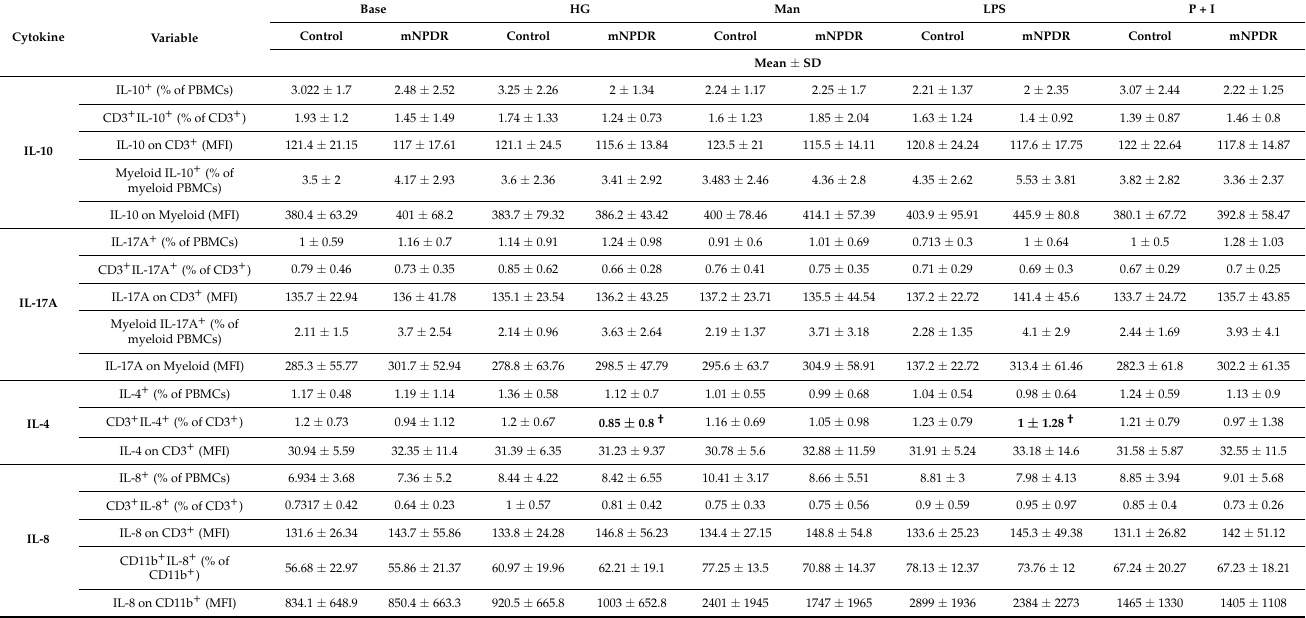
Bold mean ± SD show statistically significant differences on comparison of mNPDR patients and healthy controls. † p < 0.05 in Mann Whitney test. Base (Baseline); HG, D-glucose (25 mM); LPS ( E. coli lipopolysaccharide); Man,